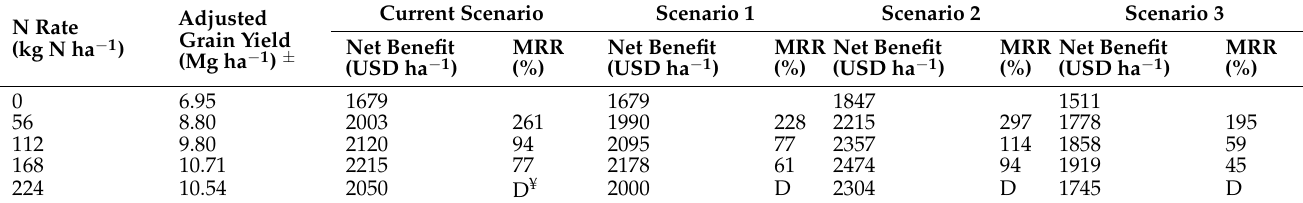
Table 5. Economic analysis of N fertilizer application rates showing maize grain yield, net benefit, and marginal rate of return (MRR) under different scenarios when data combined over years (2019 and 2020) and N fertilizer application time at the Swan Lake Research Farm, near Morris, MN. All currency in